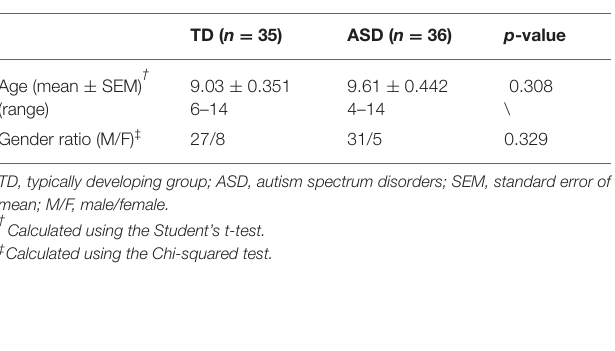
TABLE 1 | Demographic information of the